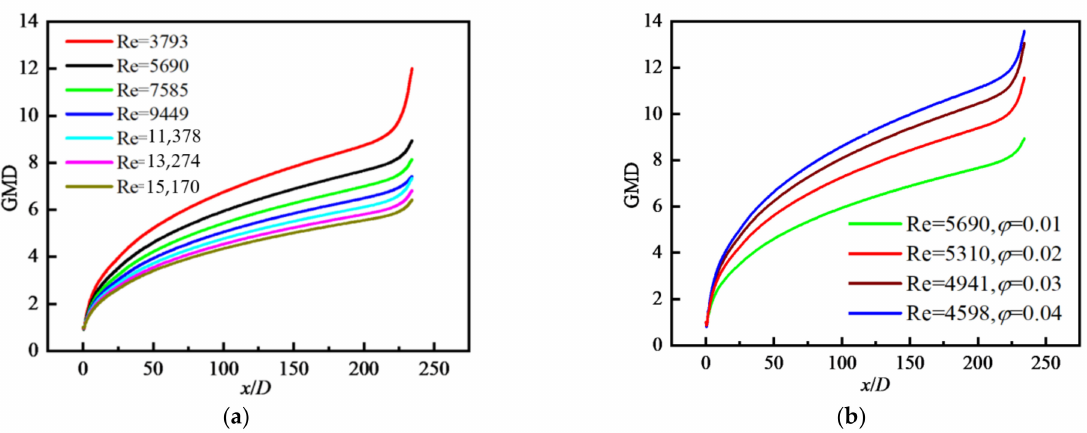
Figure 9. Distribution of GMD along the flow direction with different ϕ : ( a ) ϕ = 0.01; ( b ) at fixed Re and ϕ .